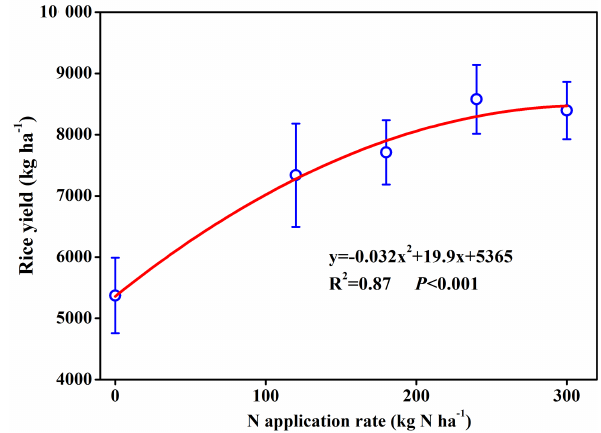
Figure 2. Relationship between N fertilizer application rate and av- erage rice yield over the two rice-growing seasons of 2013 and 2014 in the Taihu Lake region. The vertical bars represent standard